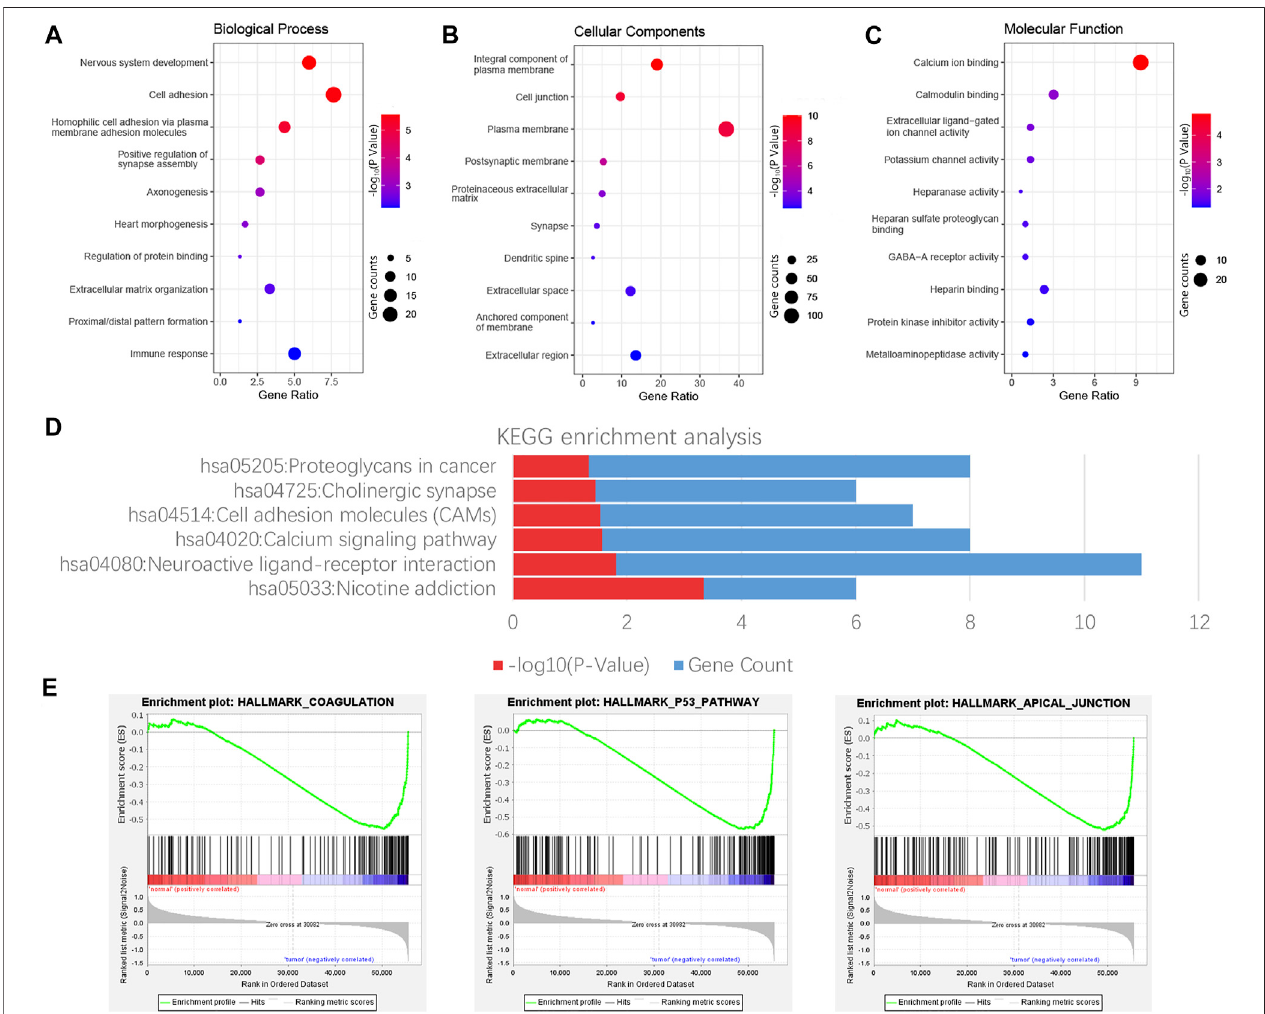
FIGURE 3 | Functional enrichment analysis of consensus genes. GO enrichment analysis results include Biological process (BP), cell composition (CC), and molecular function (MF), and each part displays 10 terms (A – C) . The result shown by KEGG is six possible signature pathways for enrichment of consensus genes (D) . Pathway enrichment plots of three gene sets by performing GSEA (E)